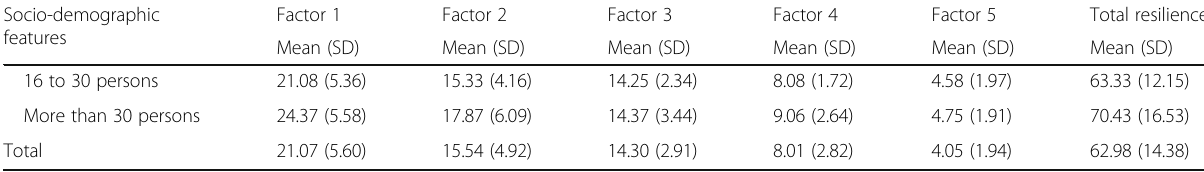
Table 2 Means and standard deviations in resilience factors according to socio-demographic variables (Continued) Socio-demographic features